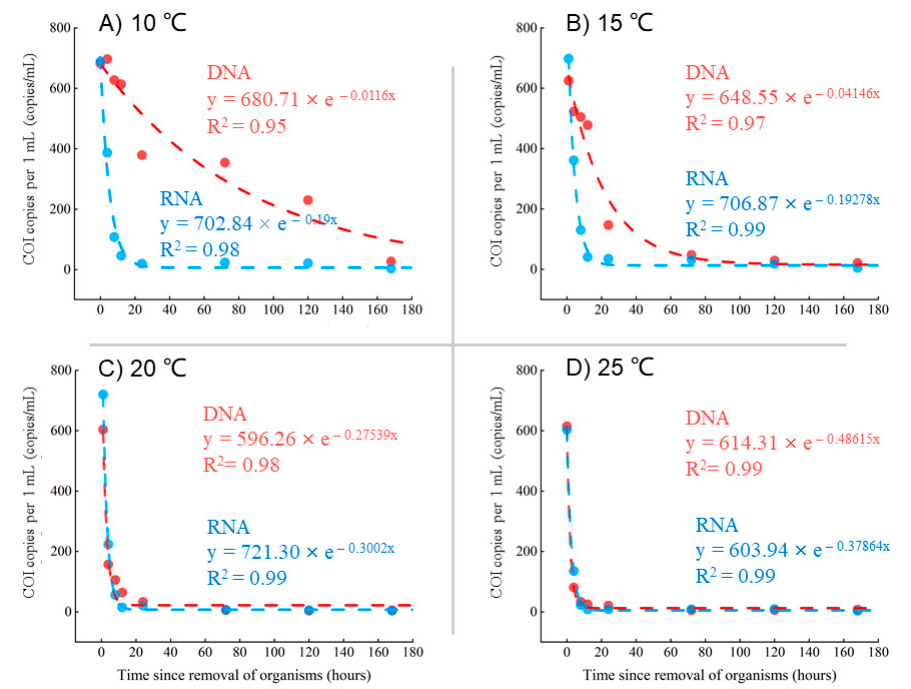
Figure 5. Time-dependent alterations in average eDNA and eRNA concentrations at: ( A ) 10 °C; ( B ) 15 °C; ( C ) 20 °C; and ( D ) 25 °C. After applying the degradation model N(t) = N 0 e −λ t to all raw data, the equations showed the rate of exponential degradation. R 2 values reflect the closeness of fit of raw data to the fitted degradation model.